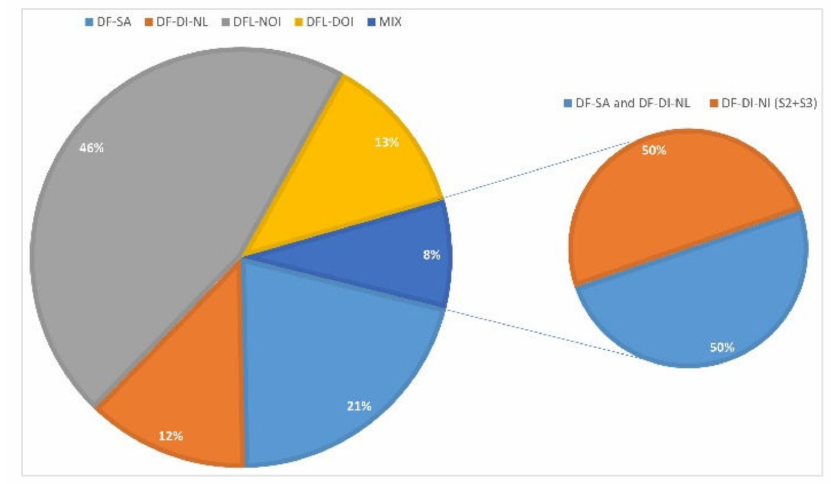
Figure 9. Number of cases within each user–façade interaction type (Authors,